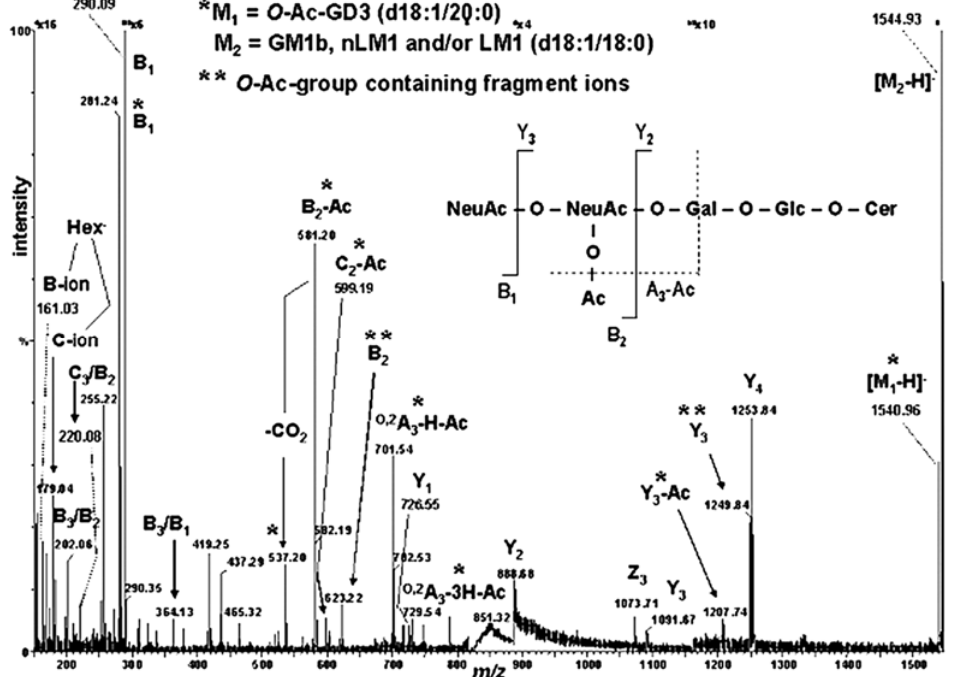
Figure 9. Negative ion mode nanoESI QTOF MS/MS of the [M-H] 2- ion at m/z 1540.96 corresponding to the O -Ac-GD3 (d18:1/20:0). ESI voltage, 1000–1250 V; for precursor ions isolation the LM and HM parameters were set to 3; collision energy: 25–40 eV; collision gas pressure: 5–10 psi.; acquisition time, 11 min; average sample consumption, 3.5 pmol. Inset, the fragmentation scheme of O -Ac-GD3 (reprinted with permission from [161]).